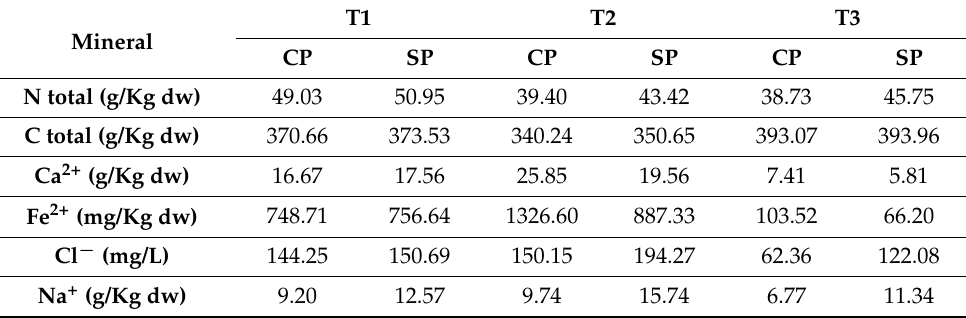
Table 3. Mineral content of dried leaves in the control (CP) and saline (SP) plots (SP). T1 and T2 include the mineral content of the whole lettuce, but T3 solely contains the mineral content of the lettuce